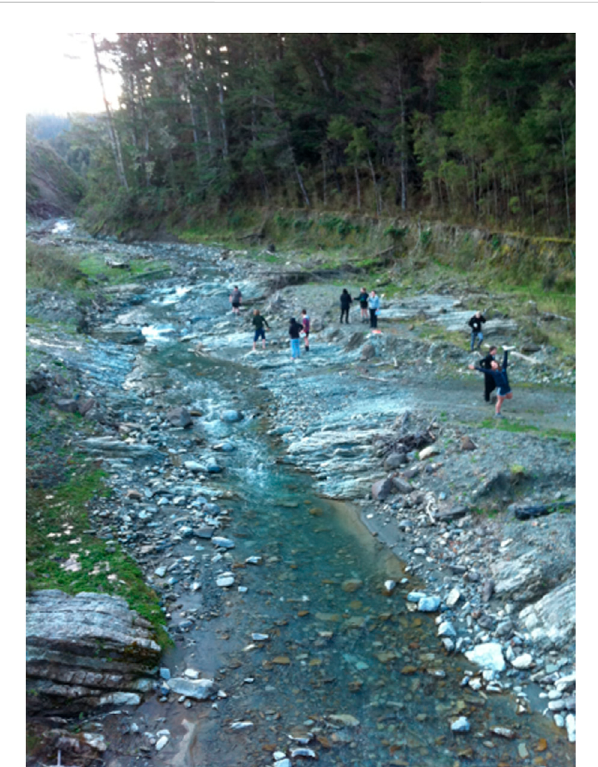
FIGURE 6 Bedrock exposed in the bed of the Weraamaia Stream, a north bank tributary of Mangaoparo River in the Waiapu Catchment (see Kasai et al., 2005; Kasai, 2006). Valley fl oor sedimentation during Cyclone Bola (1988) created the terrace visible at the edge of the tree canopy. A major storm in 1938 created similar features in upstream reaches. Photo: ICF, 28 August